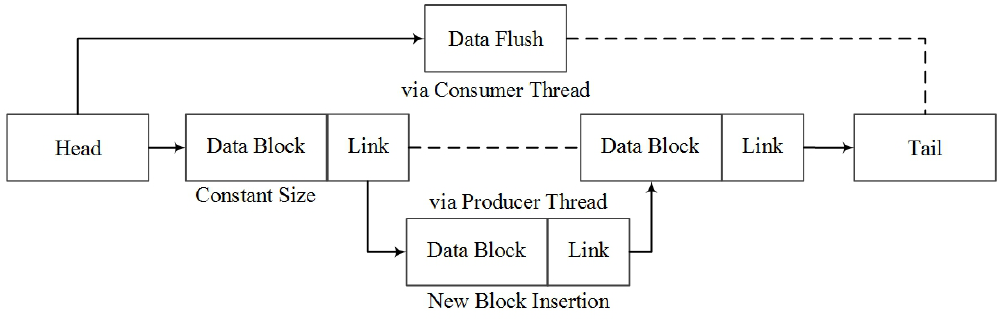
Figure 7. The blocked linked list structure for data